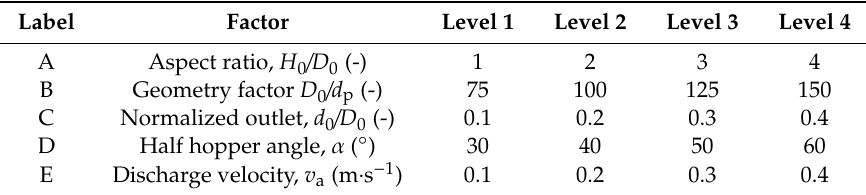
Table 3. Factors and levels considered in